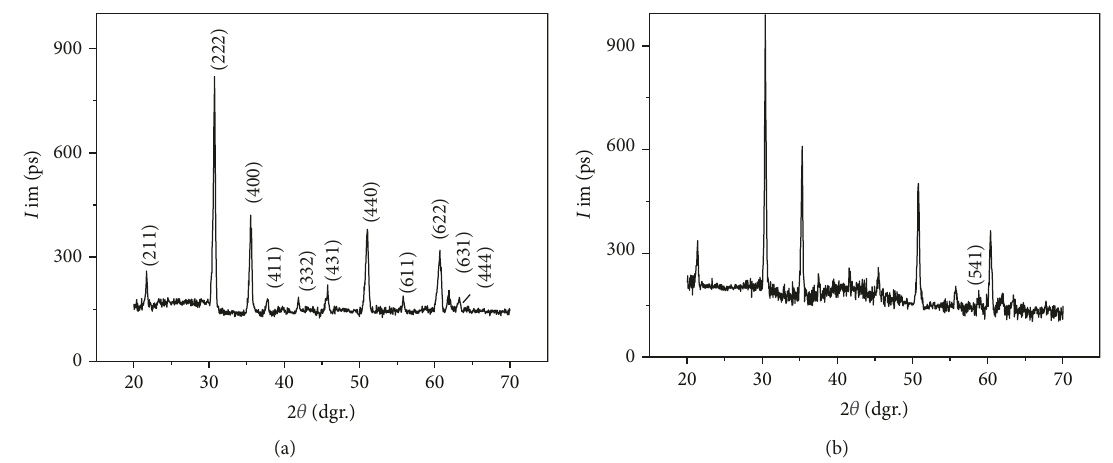
= 430 ° C ; (b) Т = 430 ° C , s s